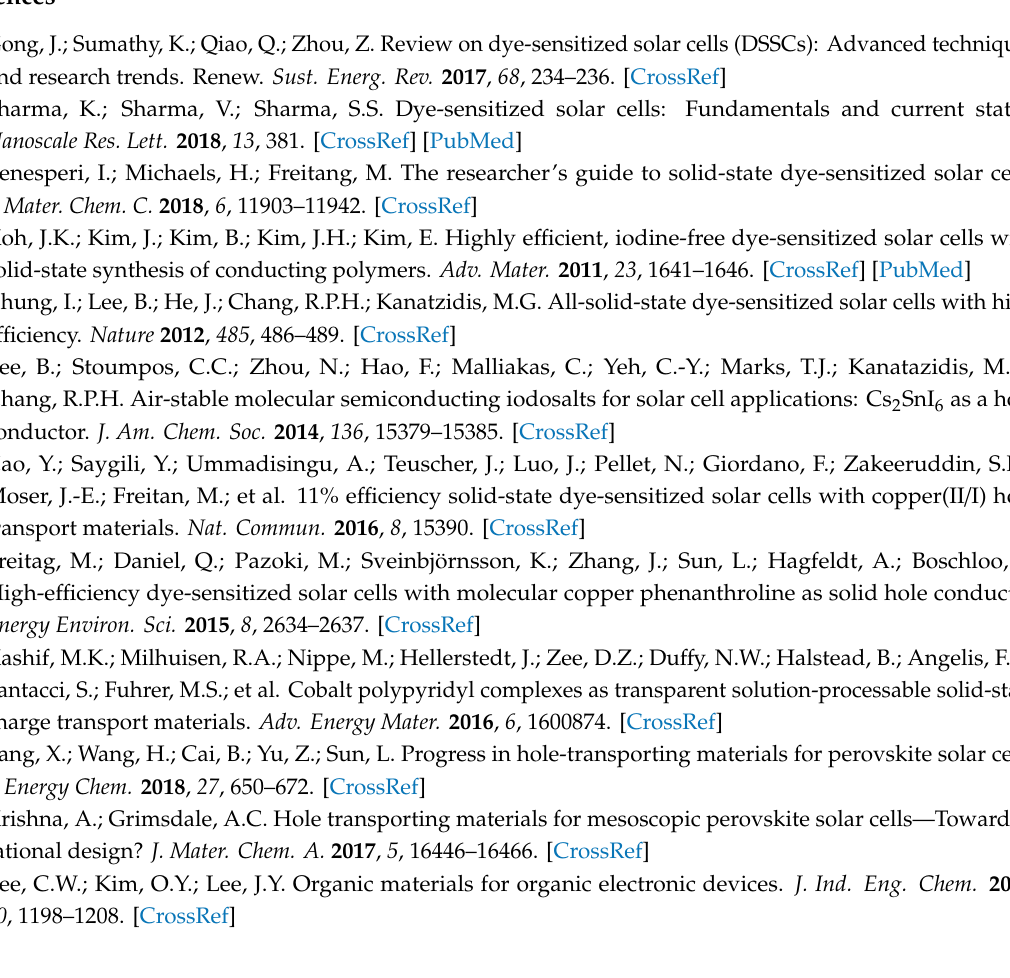
Figure S5: 1 H NMR spectrum of bis[6-bromo-N-(2-ethylhexyl)-carbazole-3-yl], Figure S6: 13 C NMR spectrum of bis[6-bromo-N-(2-ethylhexyl)-carbazole-3-yl], Scheme S2. Polymerization route to PBCzA, Figure S7: GPC elution profiles for PBCzA-H and PBCzA-L, Figure S8: Absorption and emission spectra of PBCzA in (a) solutions and (b) films, Figure S9: Photoelectron spectroscopy analysis of PBCzA-H and PBCzA-L in a thin film, Table S1: Averages and standard deviations of cell performance, which were measured using four cells with PBCzA layers. Figure S10: Cross-sectional SEM image (a) and EDS mapping images showing the distribution of carbon (b), nitrogen (c), titanium (d), and oxygen (e) in a decapped ssDSC with PBCzA-H (without additives). Figure S11: Cross-sectional SEM image (a) and EDS mapping images showing the distribution of carbon (b), nitrogen (c), titanium (d), and oxygen (e) in a decapped ssDSC with PBCzA-L (without additives). Table S2. Averages